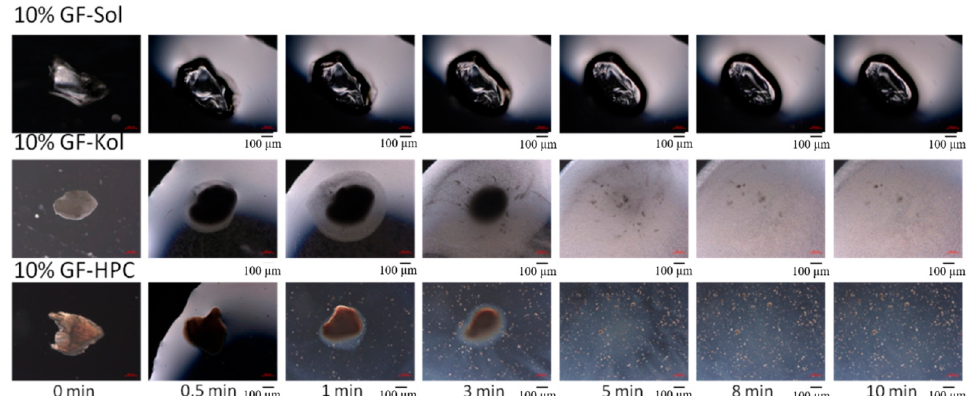
Figure 6. Digital microscope images showing the morphological evolution of a 10% GF ‐ Sol (ASD) particle, a 10% GF ‐ Kol (nanocomposite) particle, and a 10% GF ‐ HPC (nanocomposite) particle in 3 μ L deionized water. Scale bar is identical for all images: 100 μ m.